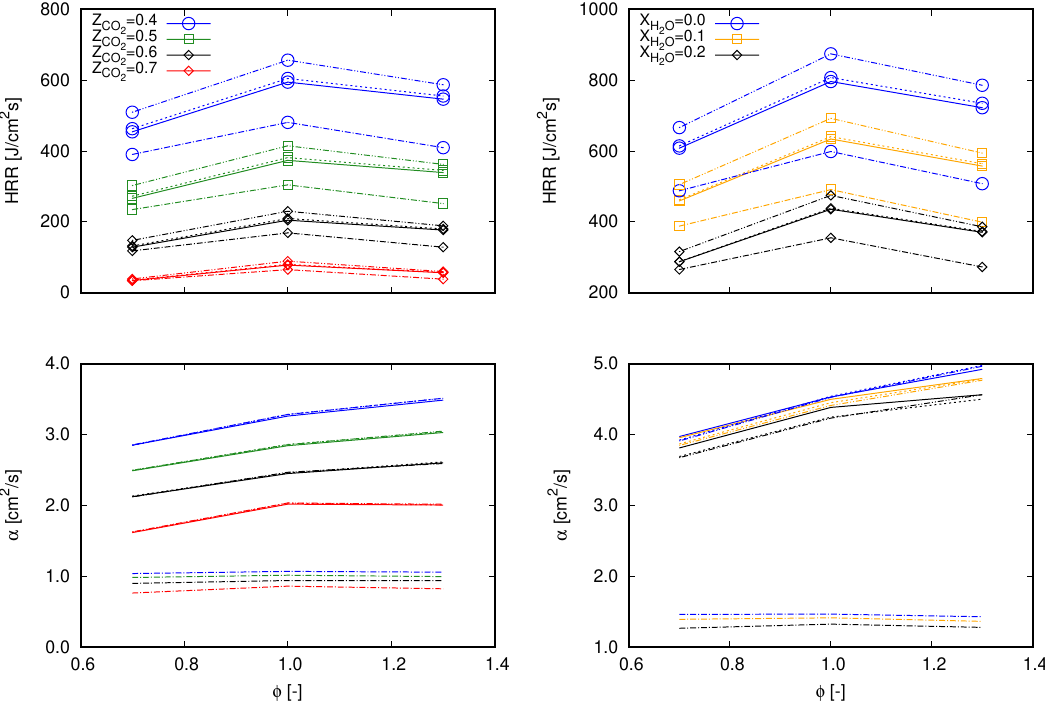
Figure 8. Values of HRR (lines with marks) and α (lines without marks) for φ = 0.7, 1.0, and 1.3 computed with different diffusion transport modeling strategies. Continuous lines, complex; dashed lines, mixture-averaged without thermal diffusion modeling; dash-dot-dot lines: mixture-averaged with thermal diffusion modeling; dash-dot lines, unitary Lewis number. ( left ) CO 2 dilution; and ( right ) H 2 O